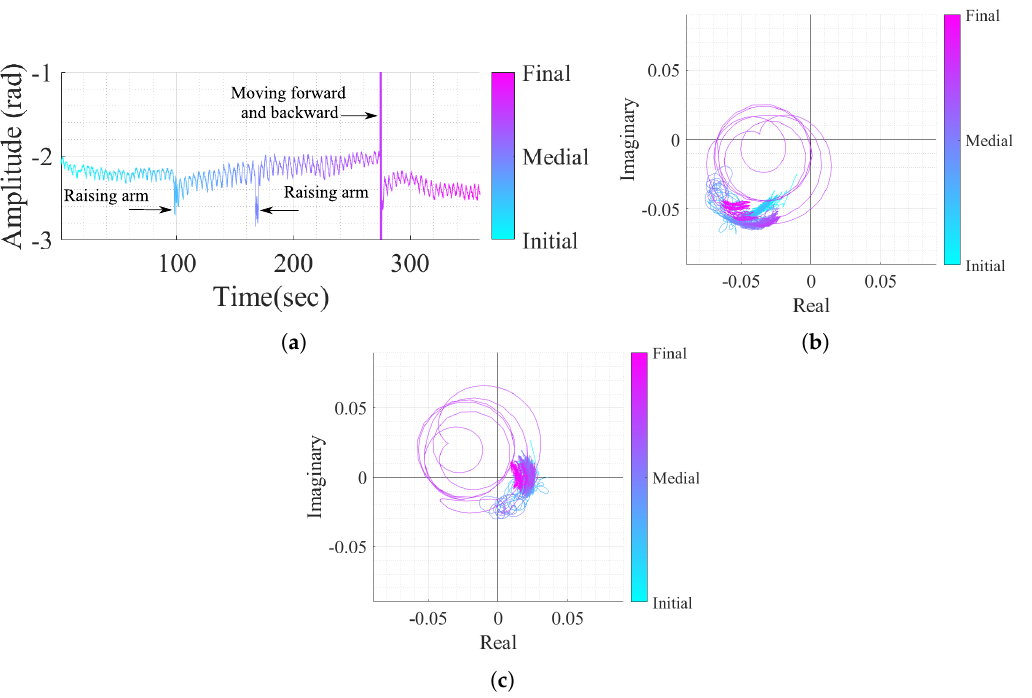
Figure 18. Case study 4 containing vital signs with body motion: ( a ) Time domain signal with CDC offsets, ( b ) Real/Imaginary plots with CDC offsets, ( c ) Real/Imaginary plots after the DSP algorithm (without the CDC